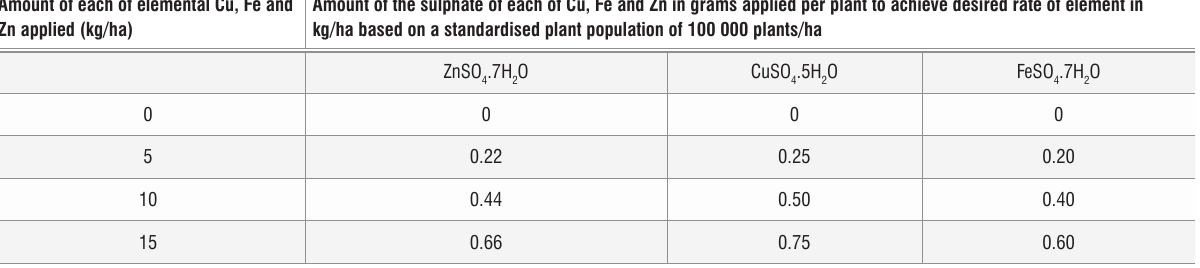
Combinations of the sulphates of Cu, Fe and Zn to achieve the desired micronutrient treatments used in the experiment Amount of each of elemental Cu, Fe and Amount of the sulphate of each of Cu, Fe and Zn in grams applied per plant to achieve desired rate of element in Zn applied (kg/ha) kg/ha based on a standardised plant population of 100 000